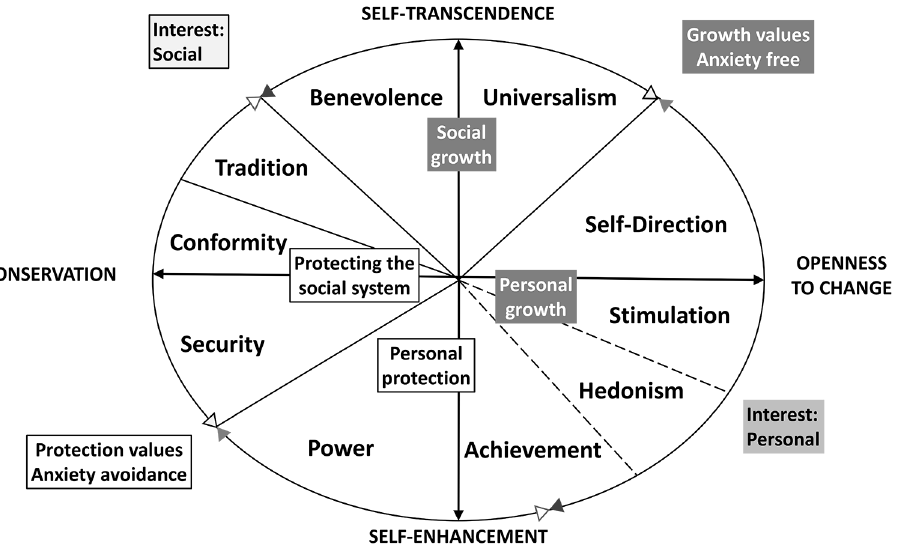
Figure 1. The theoretical structure and dynamic contrasts of basic human values (Schwartz 1992, 2016; Schwartz et al.,